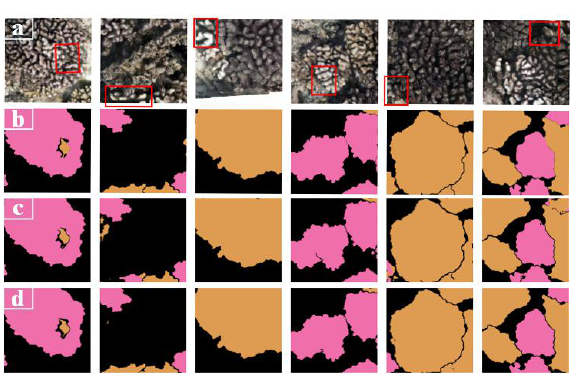
Figure 9 . Comparison of our results on the test set. (a)